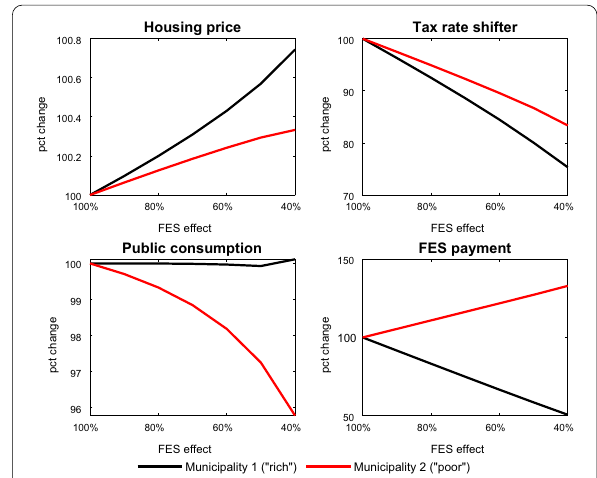
Fig. 2 Phasing-out the FES: relative change of municipality characteristics